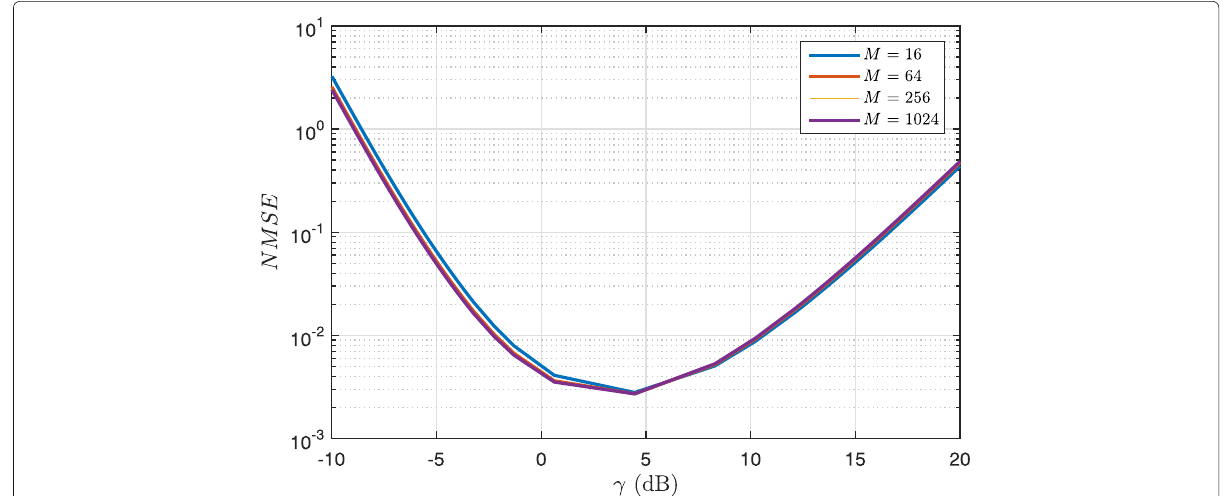
Fig. 9 NMSE of the estimate ˆ γ as a function of the SNR in dB, N = 5 × 10 4 , η − μ fading for η = 0.1 and μ = 0.6, and different orders of the M -QAM